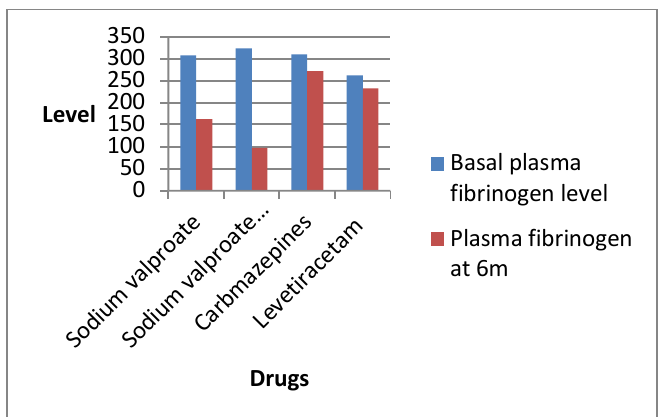
(Figure 2): Changes in the Plasma fibrinogen level in the drug-treated groups upon the administration of the drugs for a total period of 6 months Figure(2) prevelance of bleeding according to drug used